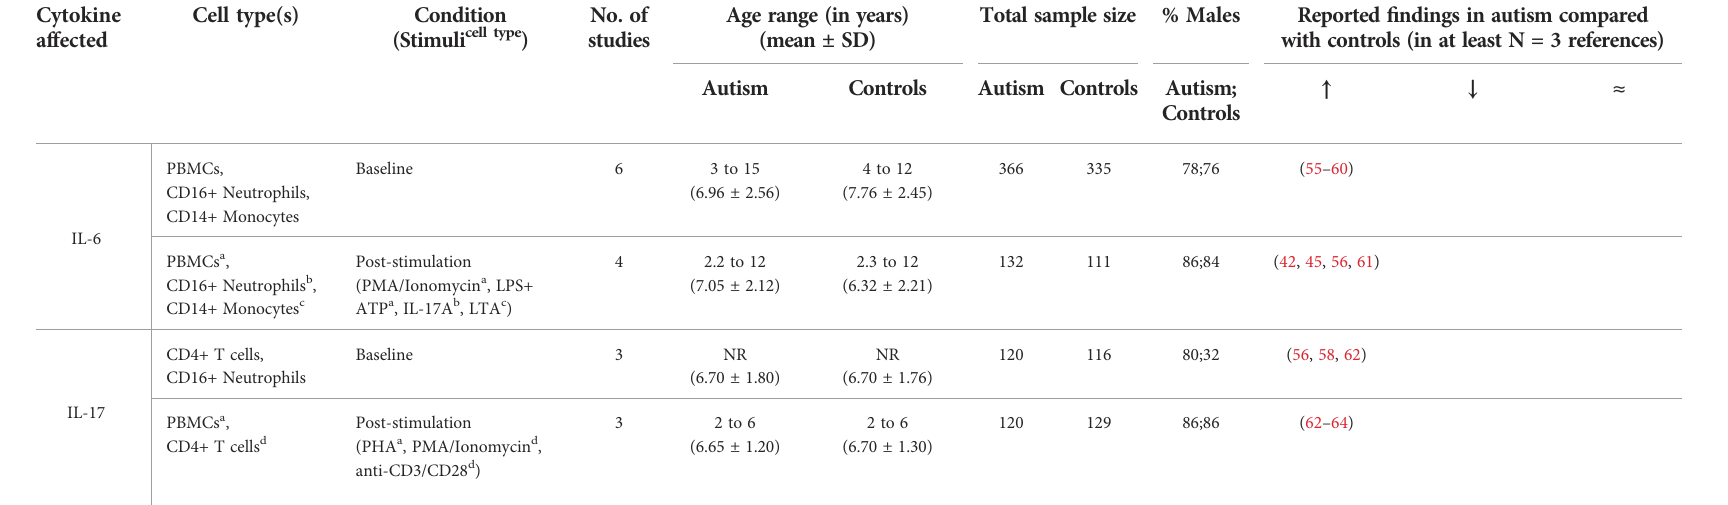
with controls (in at least N = 3 references) Controls